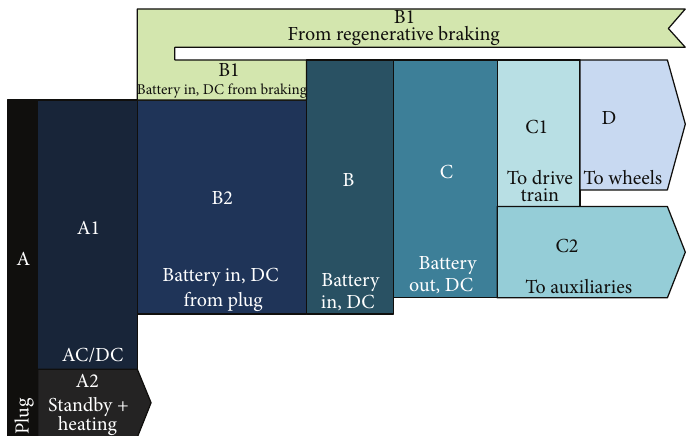
Figure 2: Energy losses from plug to the wheels of battery electric vehicles. Source: [32].